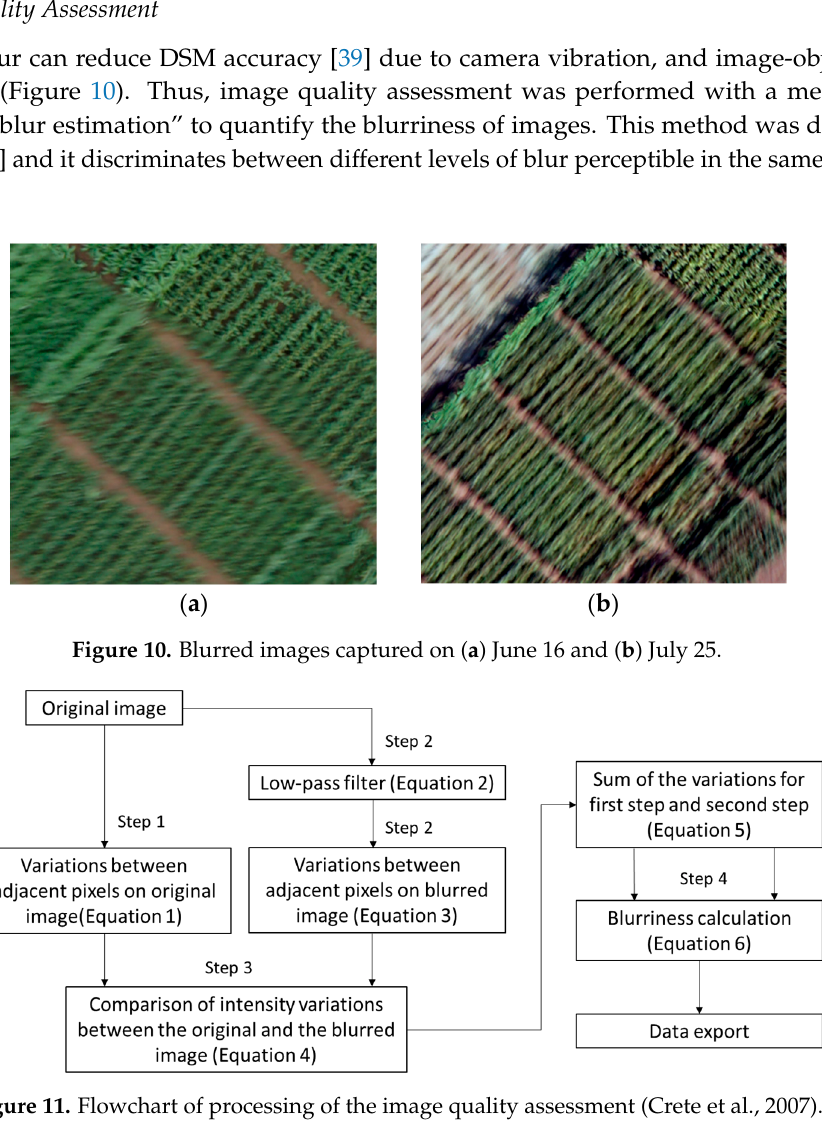
Figure 11. Flowchart of processing of the image quality assessment (Crete et al., 2007).